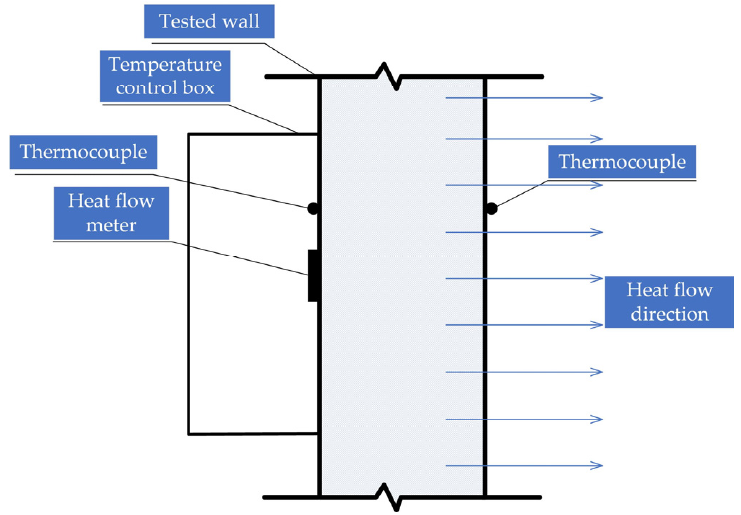
Figure 4. Schematic diagram of the temperature control box-heat flow meter test.